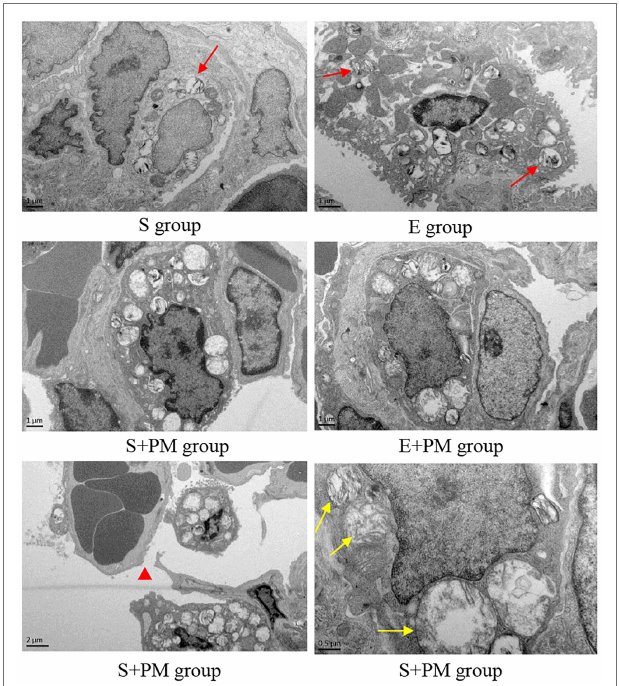
FIGURE 4 | Electron micrograph of lung tissue in different groups. Red arrows indicated lamellar bodies; red triangle indicated Basement membrane cracked after PM 2.5 exposure; yellow arrows indicated mitochondrial swelling and vacuolization in the S + PM